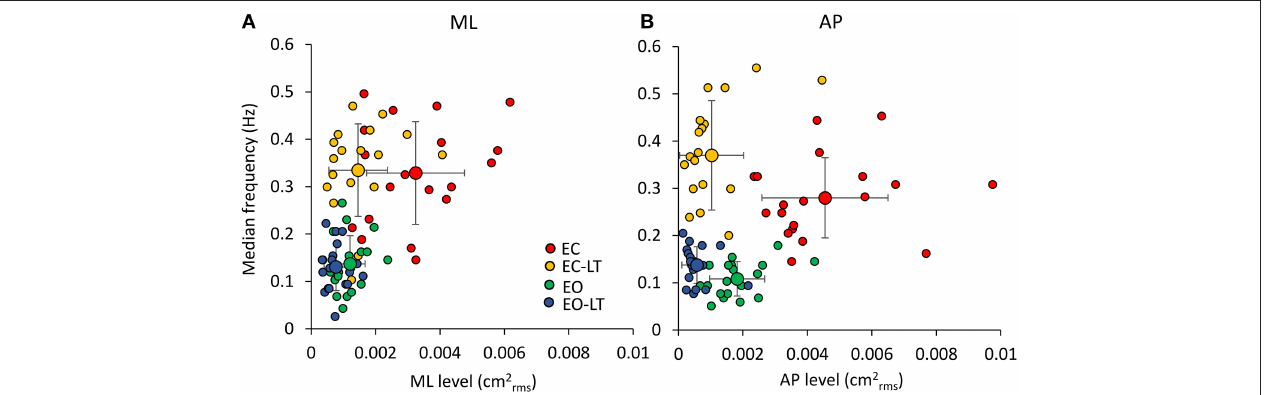
FIGURE 7 | Relationship between median frequency and mean level of the spectrum. There is a weak relationship between the value of the median frequency and the mean value of the entire spectra in each subject ( n 19), in both the frontal (A) and the sagittal planes (B) . The relatively large variability across subjects is = underscored by the plots. However, when the mean values of each of the coloured clusters are considered (the large circles with their SDs), it appears that vision (EO, green) and vision and touch (EO-LT, blue) feature small oscillation frequencies with small oscillation amplitudes. Without vision, however, touch clearly reduces the mean level (EC-LT, yellow) compared to no-vision (EC, red), while the oscillation frequencies are hardly changed, particularly along the ML direction.